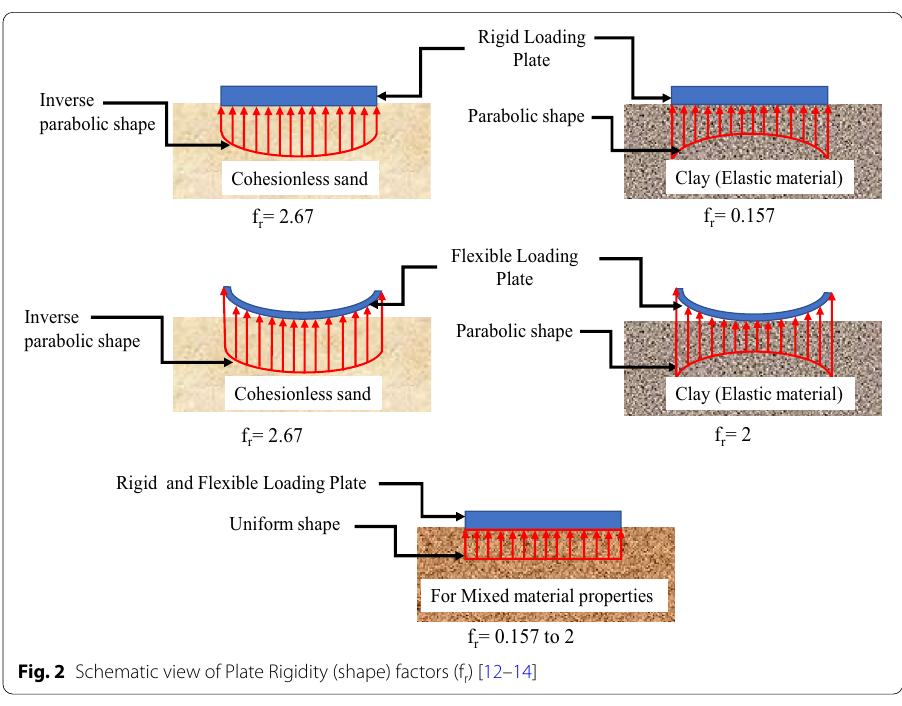
Fig. 2 Schematic view of Plate Rigidity (shape) factors (f r )